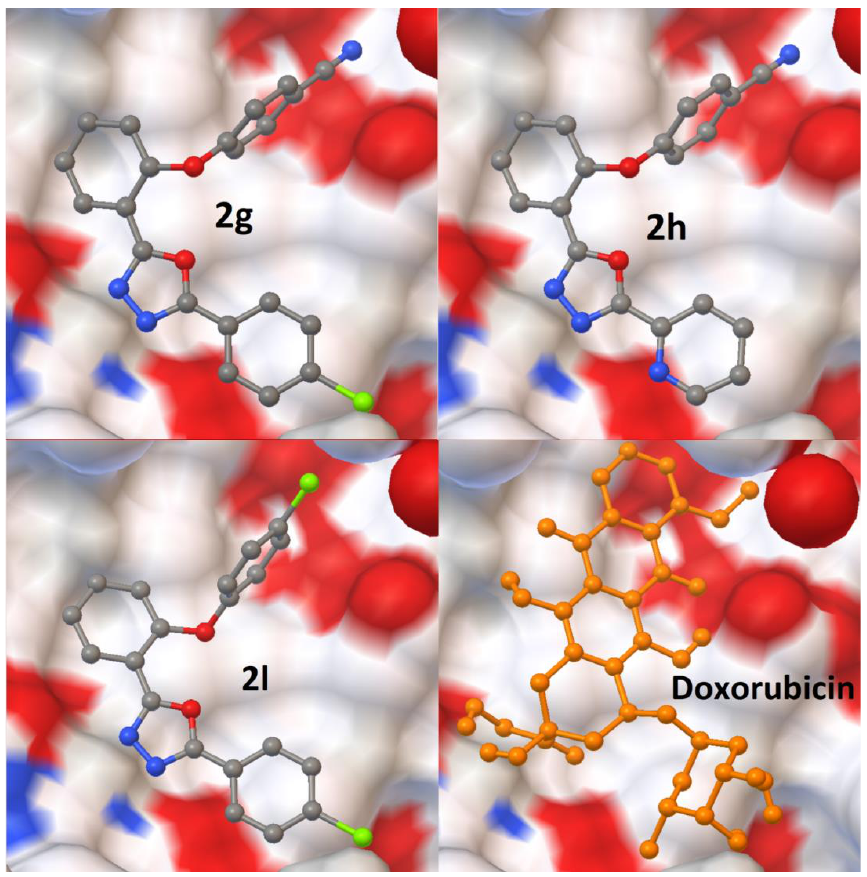
Figure 6. Interaction of the best-docked poses of compounds 4g , 4h , 4l , and reference drug doxoru- bicin to 1Z5M target.